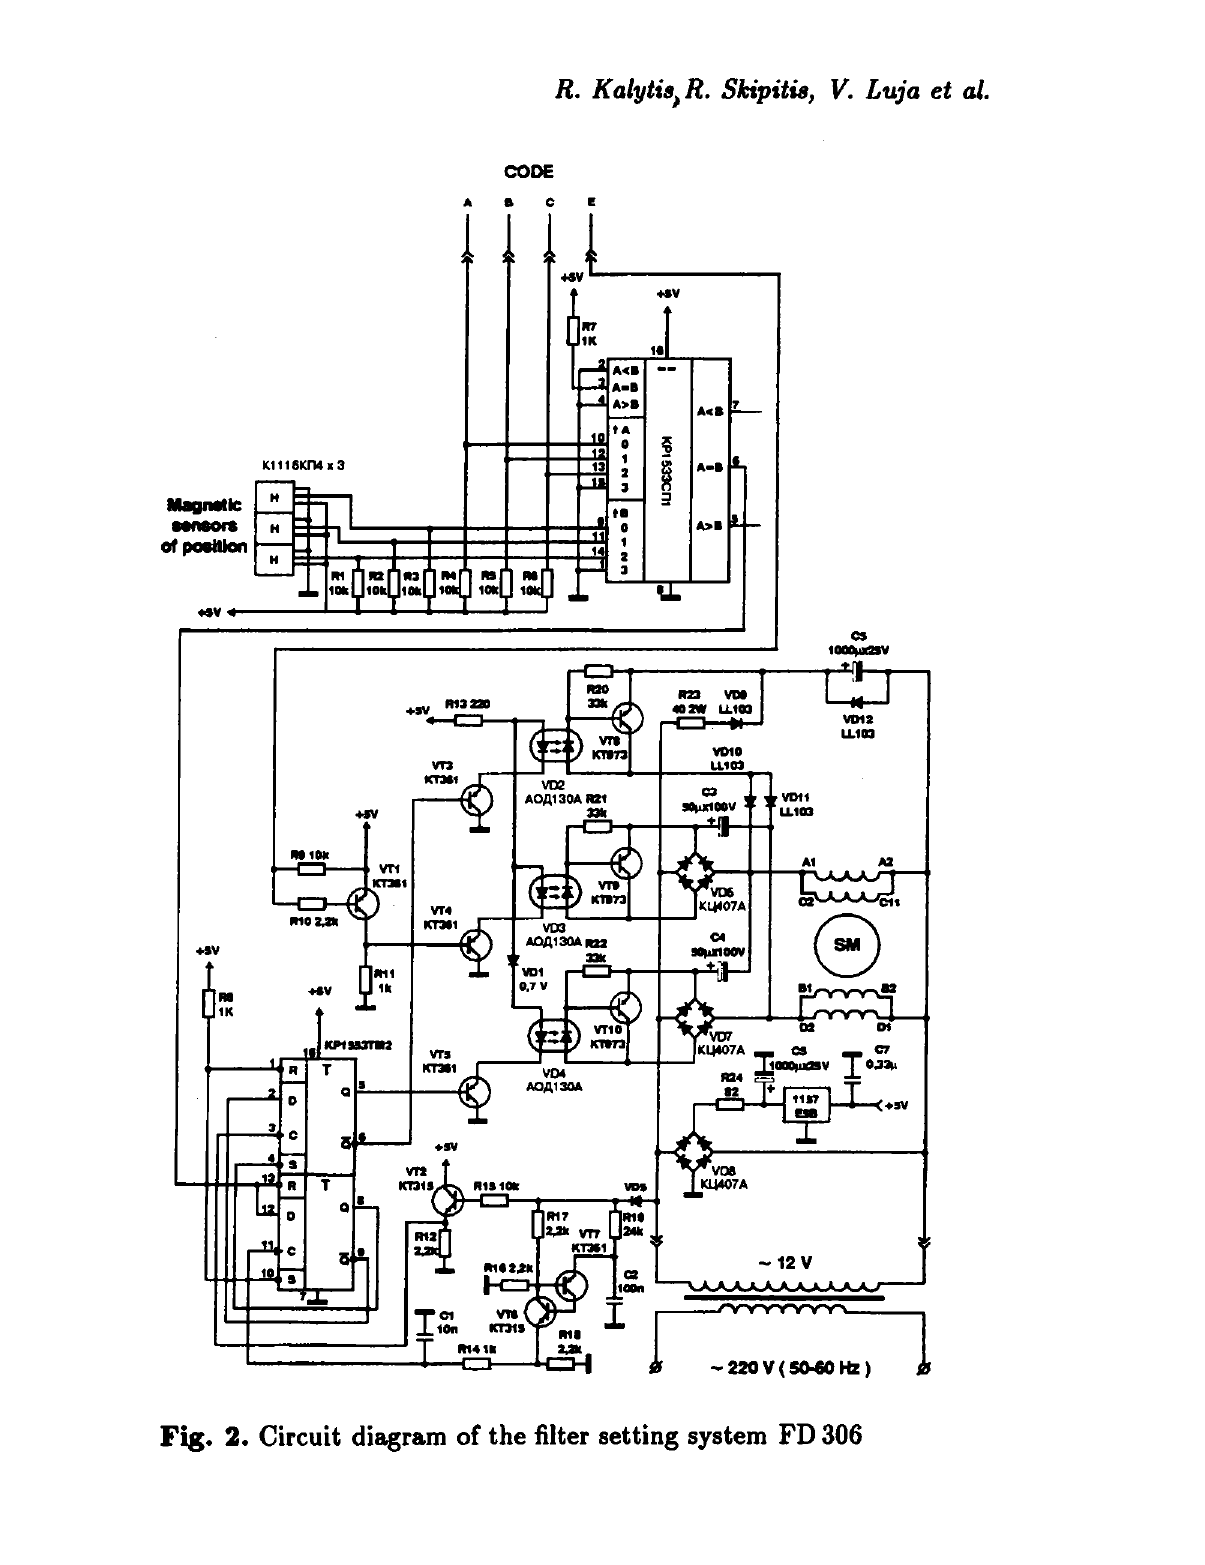
Fig. 2. Circuit diagram of the filter setting system FD